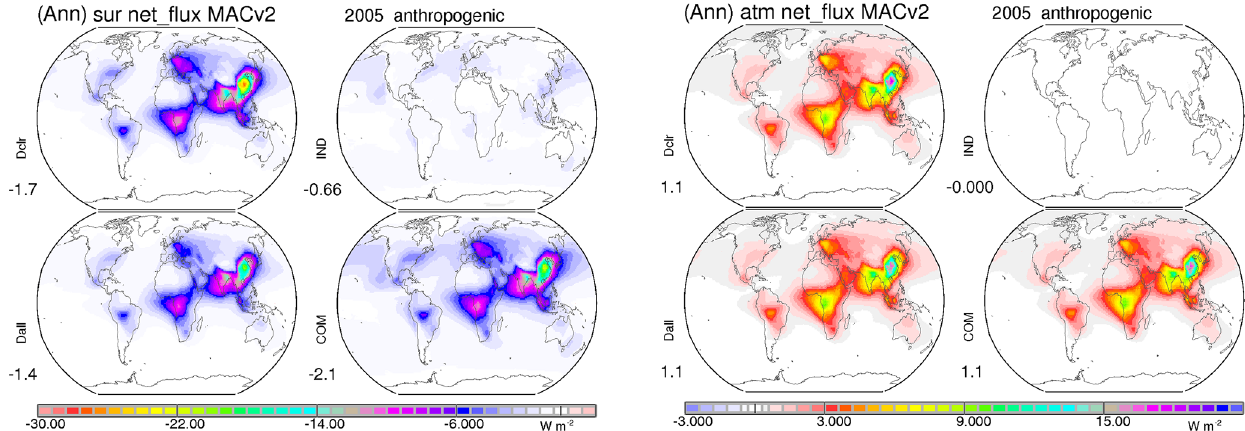
Figure 15. Annual radiative effects by present-day anthropogenic aerosol at the surface (left frame) and for the atmosphere (right frame). Maps compare direct effects for clear-sky conditions (Dclr) and all-sky conditions (Dall), indirect (Twomey) effects through modified clouds (IND) and the combined (direct and indirect) effect (COM). Blue colors indicate cooling net-flux losses and red colors indicate warming net-flux gains. Values below the labels indicate global averages.